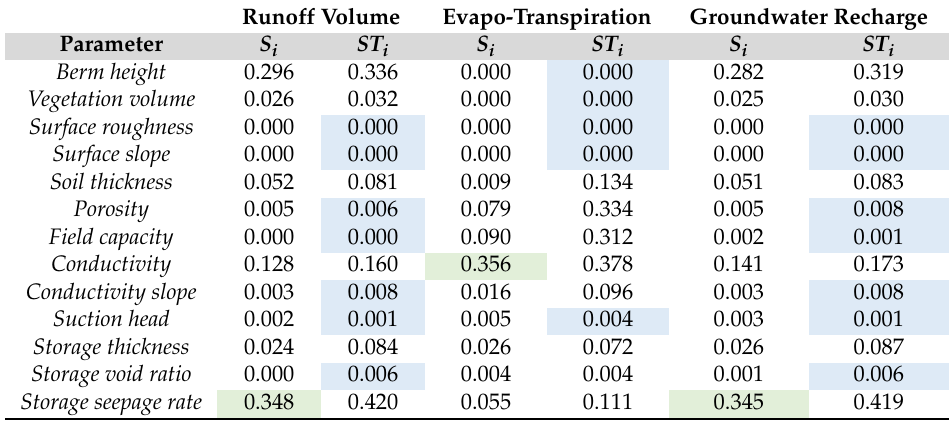
Table 4. Result of the long-term sensitivity analysis for the bio-retention cell; blue-shaded: